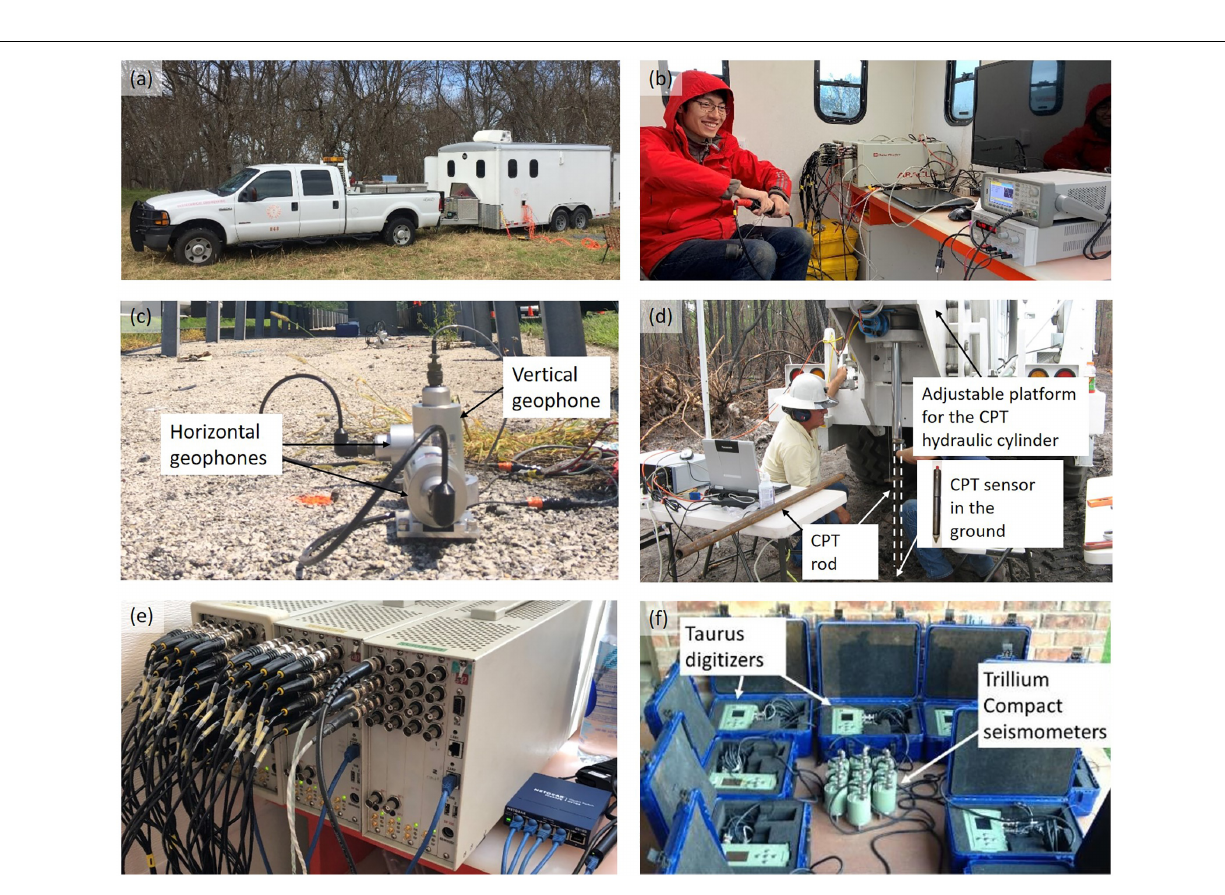
Frontiers in Built Environment |